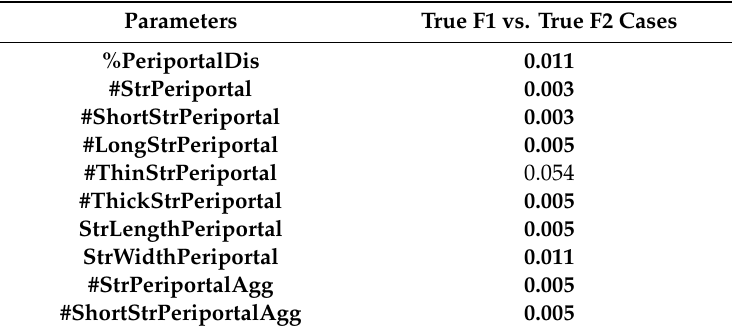
Table 6. Validation of the discriminatory